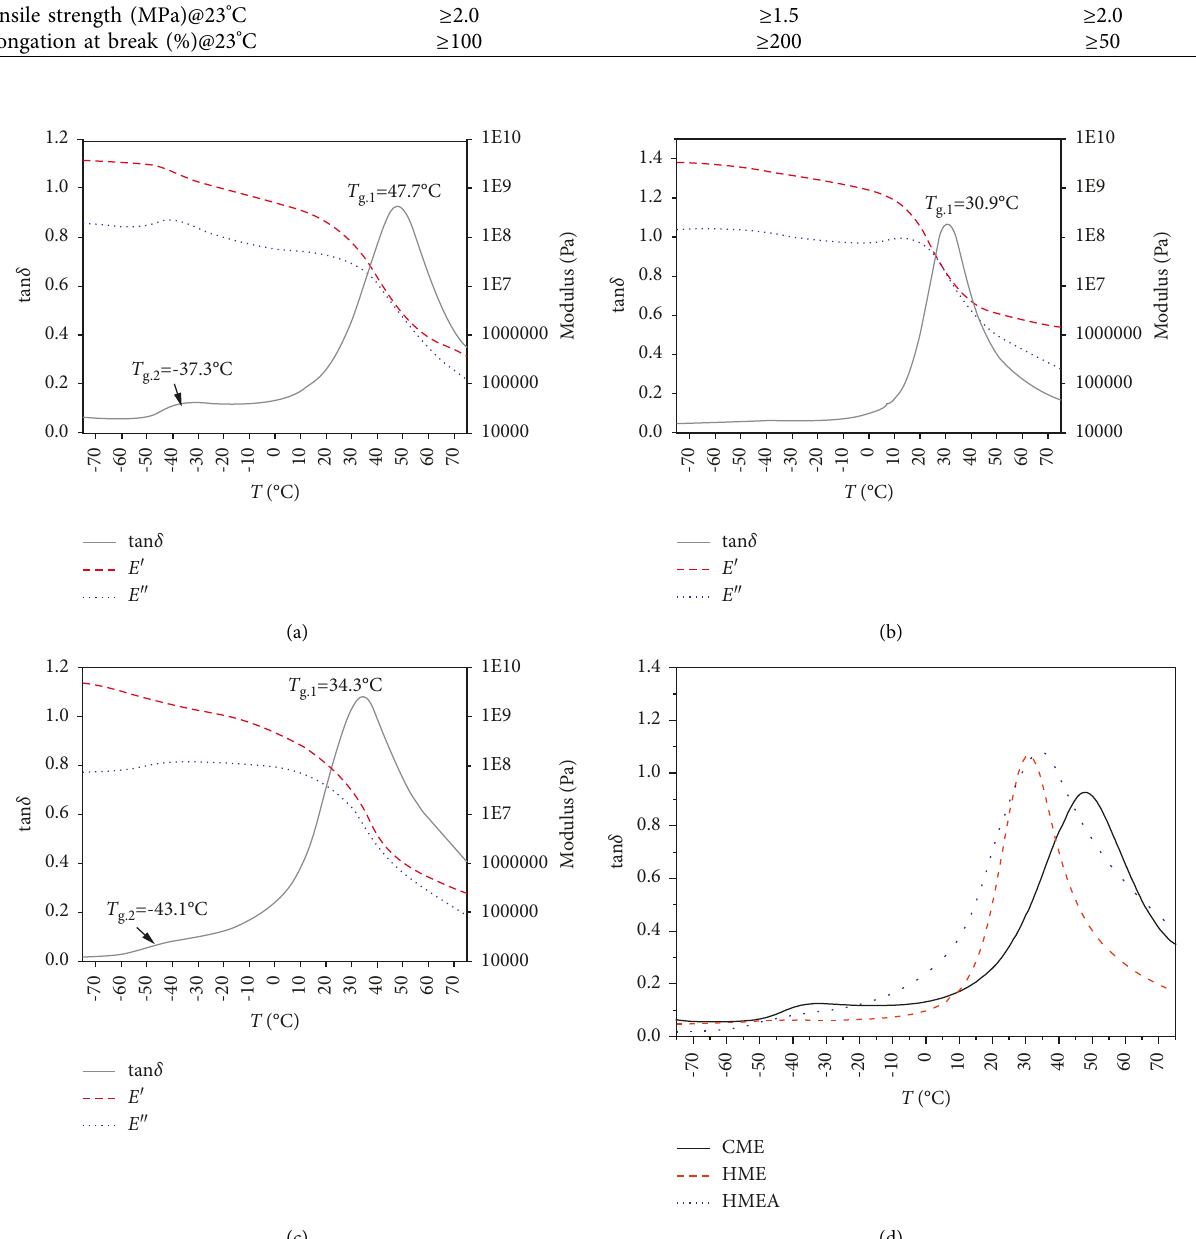
Figure 8: Dynamic mechanical properties of (a) CME, (b) HME, (c) HMEA, and (d) the comparison of tan δ